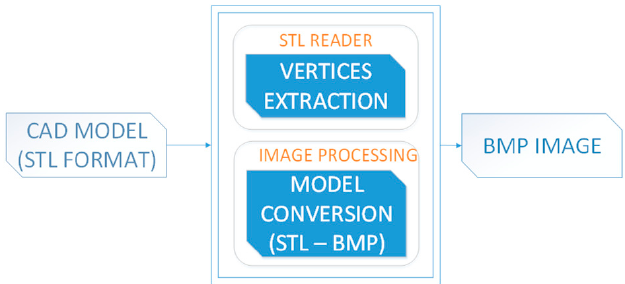
Figure 6. Block diagram of CAD to BMP processing. The STL reader imports CAD model into the MATLAB working space and extracts vertice, edge, and facet data. The image processing algorithm function further processes CAD data and creates a BMP output.